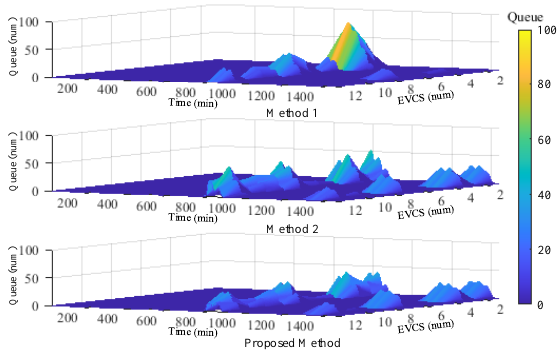
Figure 6. Comparison of queuing at EVCSs under different forecast methods.